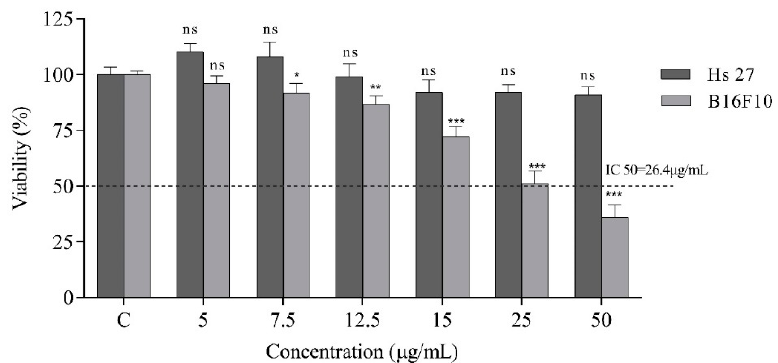
Figure 4. Antiproliferative effect of treatment by different concentrations (0–50 µg/mL) on HS-27 (normal human fibroblasts) and B16F10 (murine melanoma cells) after 24 h. Data represent the means ± SEM of at least three independent experiments (significant differences, * p < 0.05, ** p < 0.01, *** p < 0.001, n.s. no significant differences).